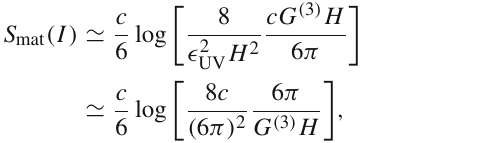
Then for the weak gravity case ( cG ( 3 ) H )/( 6 π) (cid:9) 1,